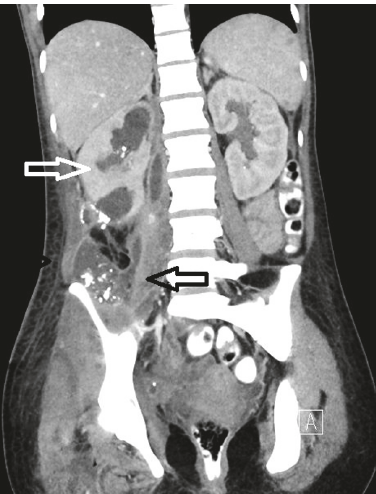
Figure 1: Computed tomography shows a completely disrupted right kidney with multiple stones (white arrow) and a large retroperitoneal abscess (black arrow).